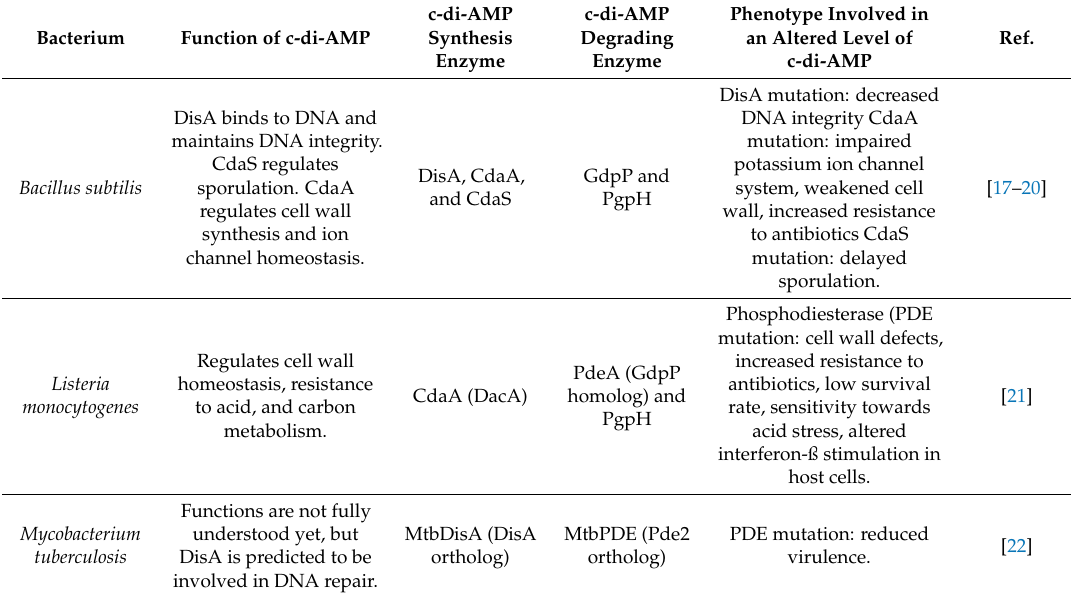
Table 1. The function of cyclic di-adenosine monophosphate (c-di-AMP) and its synthesis and degradation enzymes in